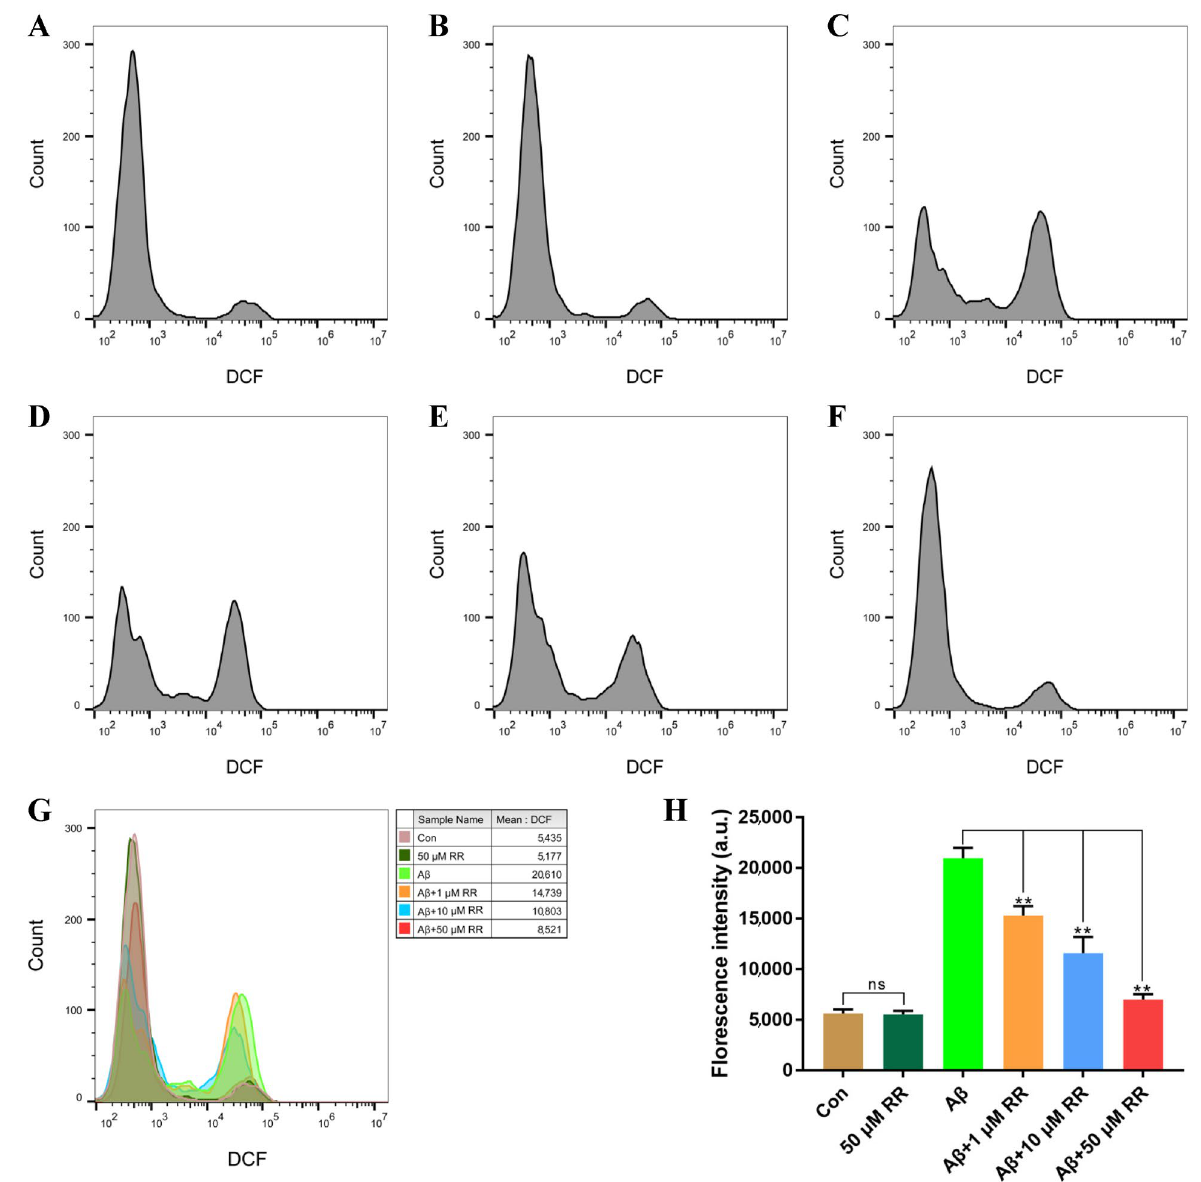
Figure 10. Flow cytometry analysis of the effects of arginine dipeptide on reactive oxygen species (ROS) production. ( A ) ROS production in Aβ 42 -nonsecreting SH-SY5Y cells treated with DMSO (Con). ( B ) ROS production in Aβ 42 -nonsecreting SH-SY5Y cells treated with arginine dipeptide (RR) at 50 µM. ( C ) ROS production in SH-SY5Y cells secreting A β 42 . ( D – F ) ROS production in A β 42